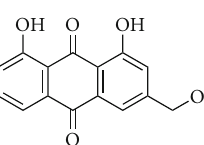
Figure 1: The chemical structure of